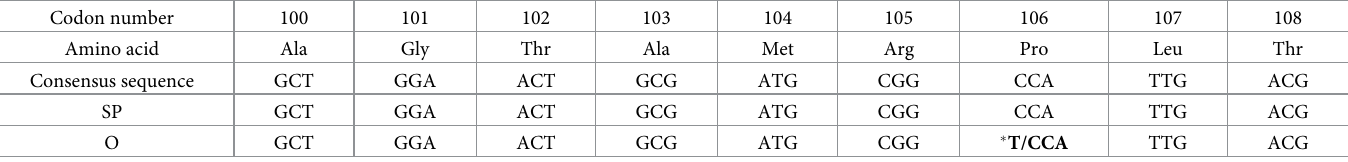
Table 2. Nucleotide sequence in EPSPS gene in glyphosate-resistant (O) and glyphosate-susceptible (SP) populations of perennial ryegrass. Changes to codons from the consensus sequence are highlighted. Codon